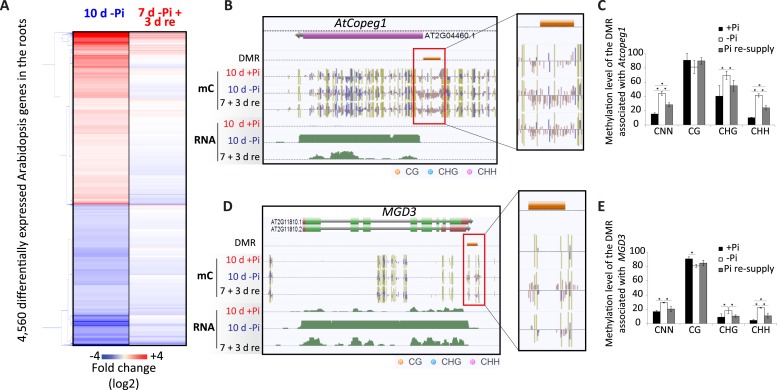
Pi starvation in Arabidopsis results in a limited number of changes in DNA methylation.(A) Hierarchical clustering of significantly differentially regulated genes upon 10 days of Pi starvation and resupply. Arabidopsis seeds were germinated and grown in either Pi sufficient (500 µM Pi) or deficient (13 µM Pi) for 10 days. After 7 days of treatment, half of the Pi starved plants were re-supplied with 500 µM Pi for 3 days. (B and C) Genome browser representation of the two Arabidopsis PSI DMRs identified in this study (FDR < 0.2). AtCopeg1 (Copia evolved gene 1) is a Copia like transposon previously shown to be induced by Pi starvation (Duan et al., 2008), while MGD3 (monogalactosyl diacylglycerol synthase 3) encodes the major enzyme for galactolipid metabolism during Pi starvation. (C and E) DNA methylation levels in the CNN, CG, CHG and CHH contexts in the three Pi treatments (+Pi, −Pi and Pi resupply) in the DMRs associated with Atcopeg1 and MGD3, respectively. Asterisks represents significant differences in the methylation level (t-test < 0.05). Source data for Figure 6 is available at Dryad (Secco et al., 2015).